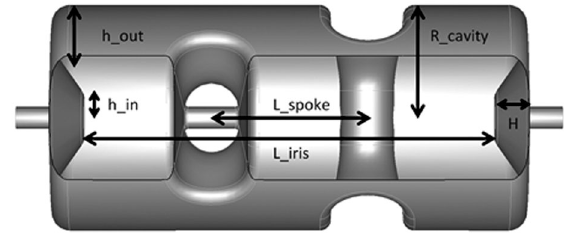
FIG. 4. Cut-away view of a two-spoke 325 MHz, (cid:1) 0 ¼ 1